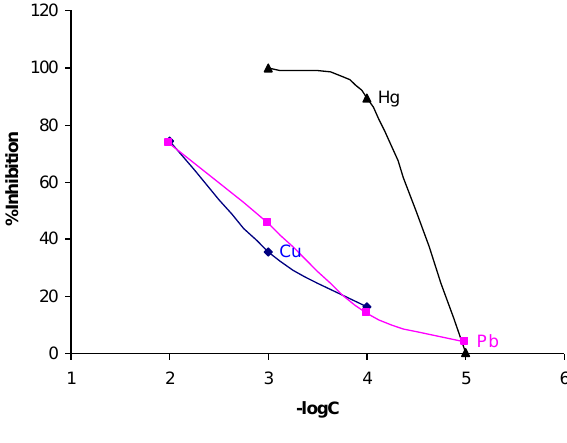
Figure 6 . Bioluminescence inhibition dose-response curves for Hg 2+ evident that Hg 2+ shows the highest toxicity when tested with the developed system.